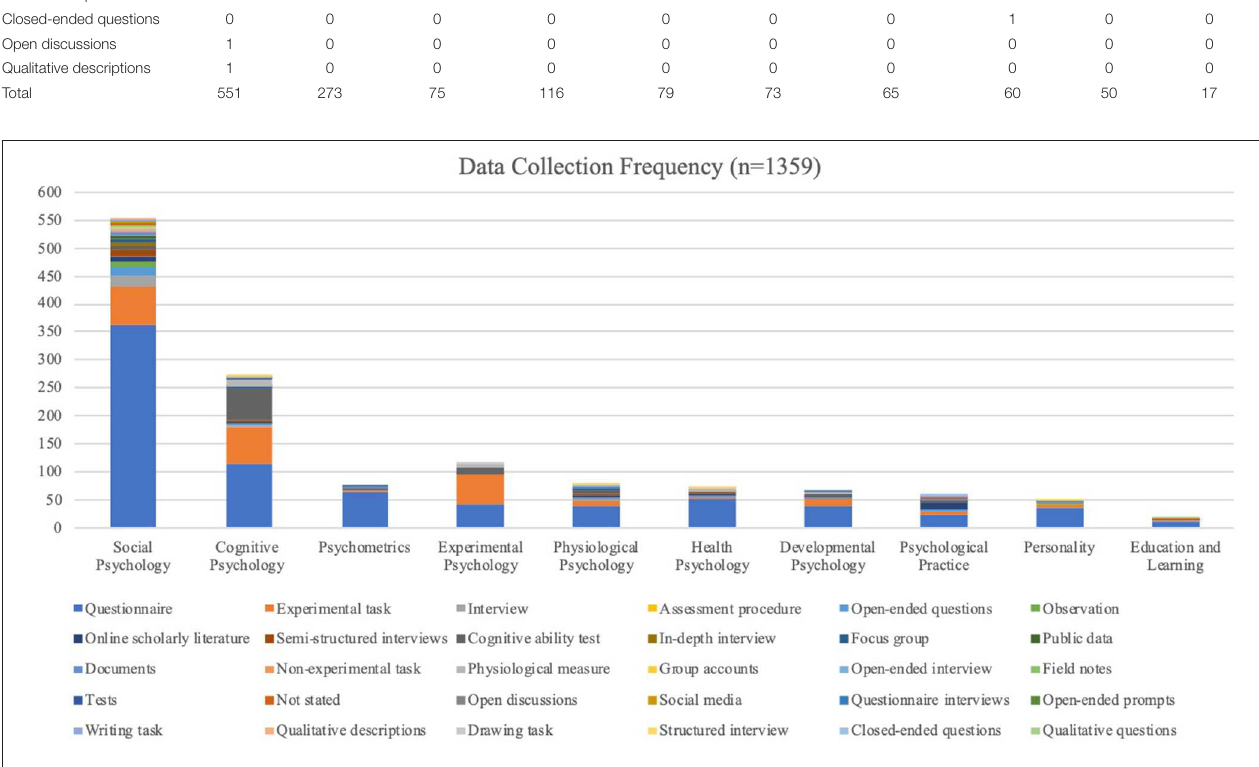
FIGURE 7 | Data collection frequency in